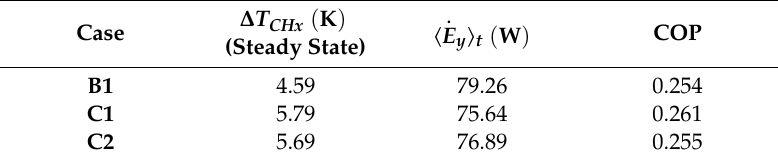
Table 4. Performance results for Celcor based material combination of stack.